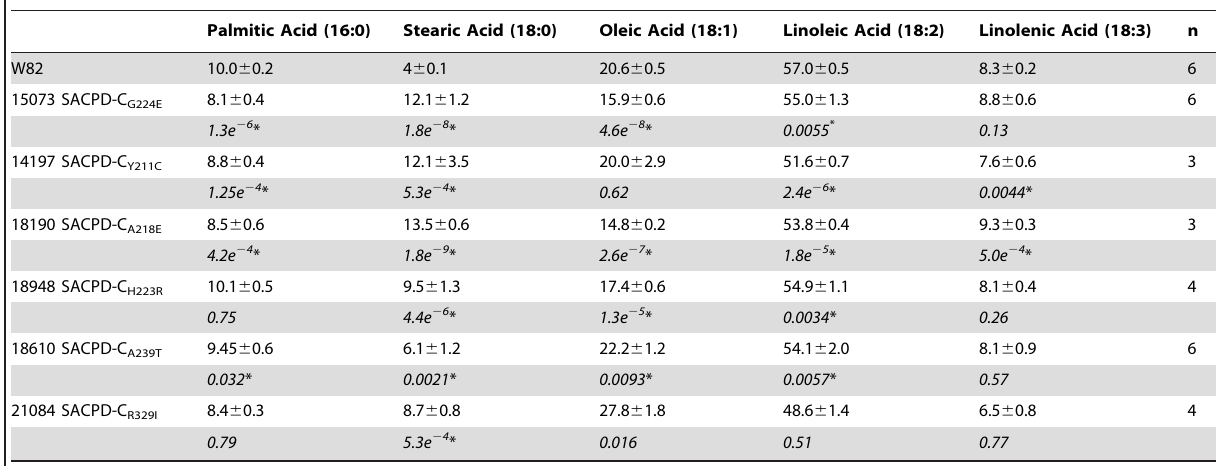
Table 1. Elevated stearic acid levels in SACPD-C mutants.